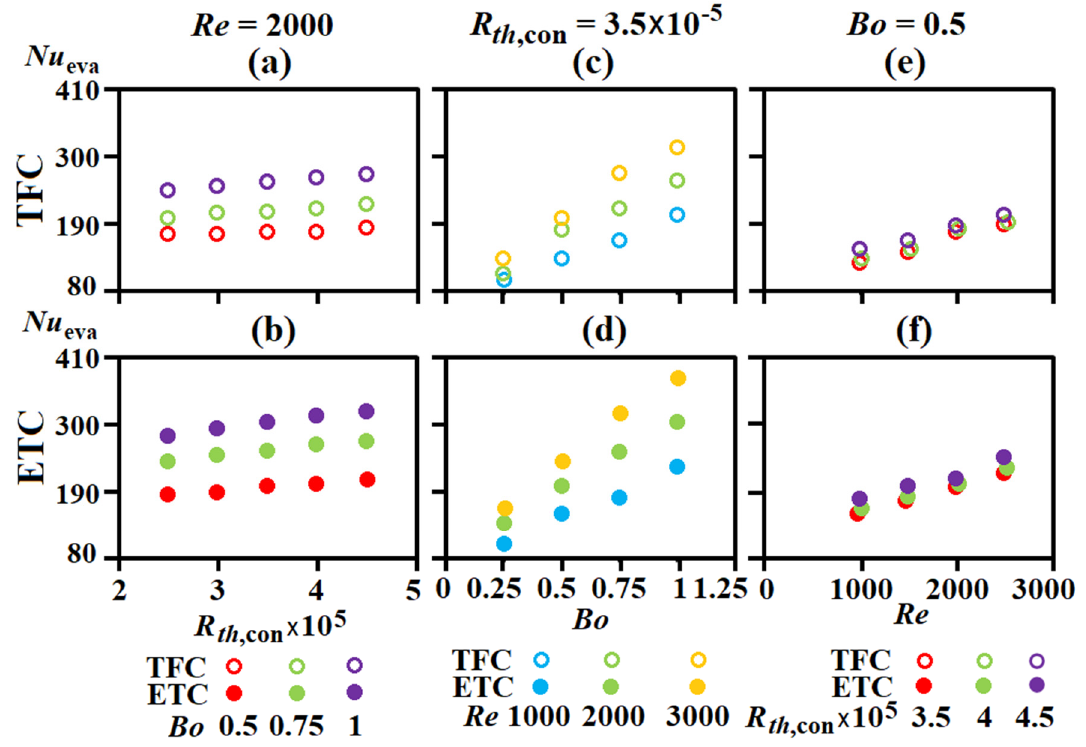
Figure 4. Variations of Nu eva along with ( a , b ) R th ,con at Re = 2000 ( c , d ) Bo at R th ,con = 3.5 × 10 − 5 ( e , f ) Re at Bo = 0.5 between the loops with TFC and ETC. The ratio of Nu eva between the loops with ETC and TFC against ( g ) Re , ( h ) Bo , ( i ) R th ,con .